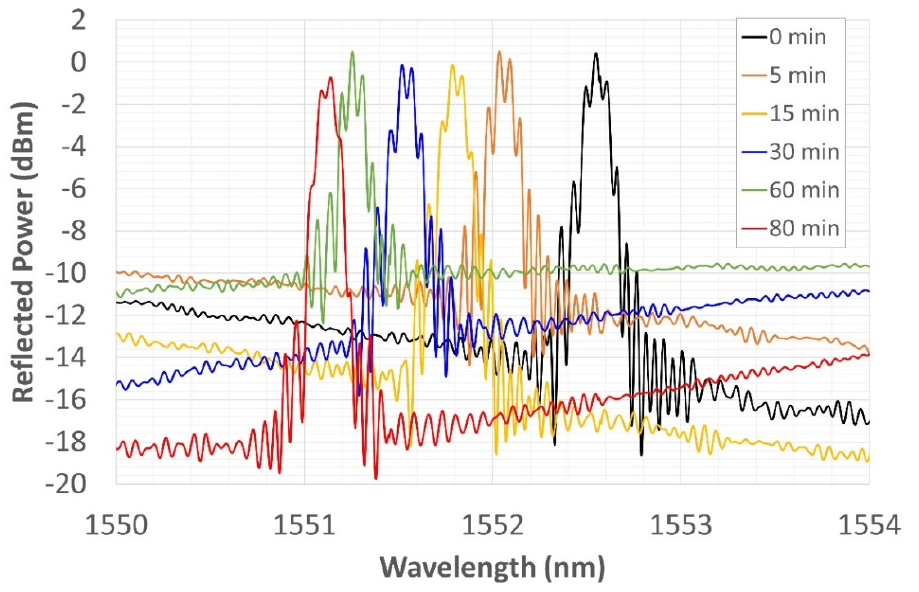
◦ C for CWL stabilization. Figure 14. Thermal stabilization cycle at 800 °C for CWL stabilization. Figure 14. Thermal stabilization cycle at 800 Table 3. Thermal stabilization cycle at 800 ◦ C; experimental